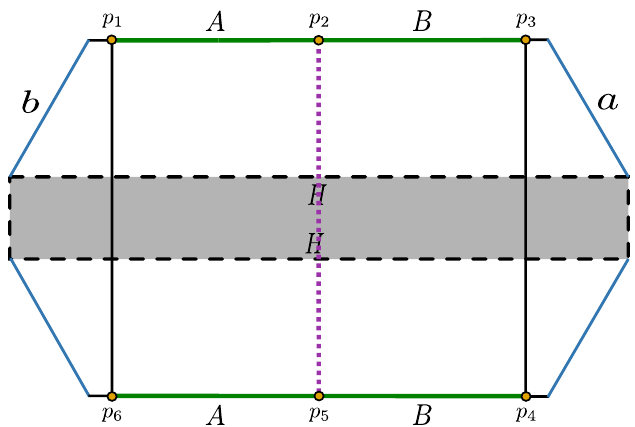
Figure 14 . The points in the two BCFT 2 copies are identified as p 2 = r and p 5 = r and the other points are identified similarly as in the figure